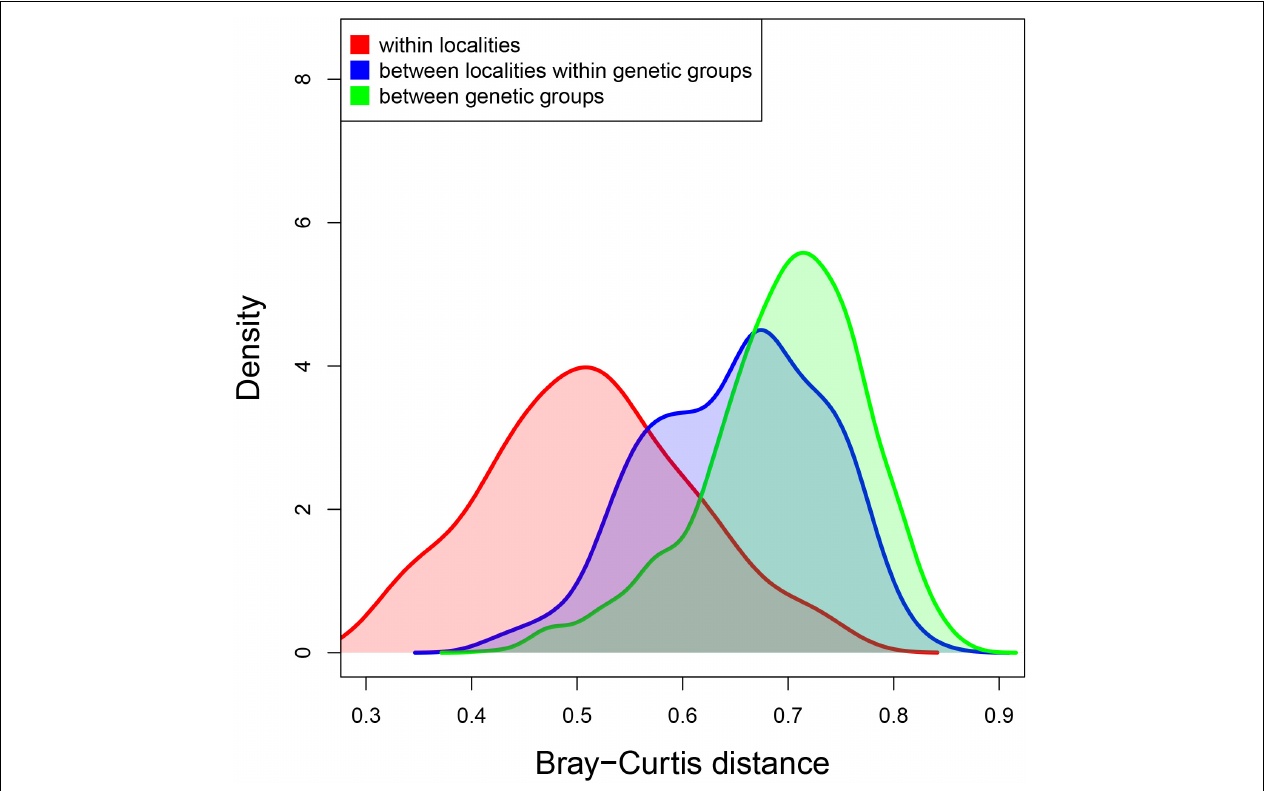
FIGURE 5 | Density plot of the Bray–Curtis distances between samples from the same locality (in red), from different localities of the same genetic group (in blue) and from different genetic groups (in green). Genetic groups of introduced populations are those identified in Casso et al. (2019b).